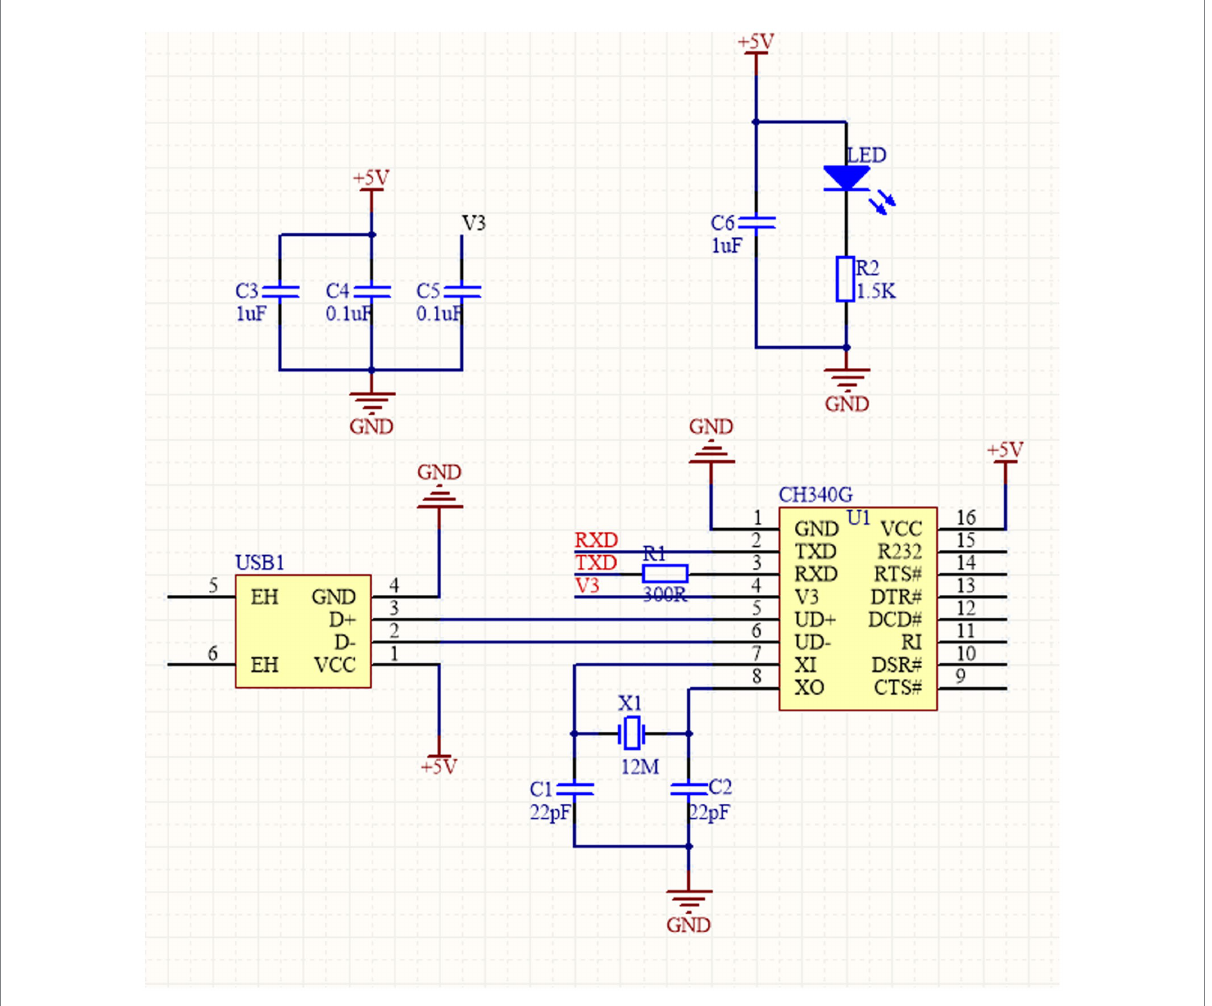
FIGURE 2 Sensor data communication module circuit.